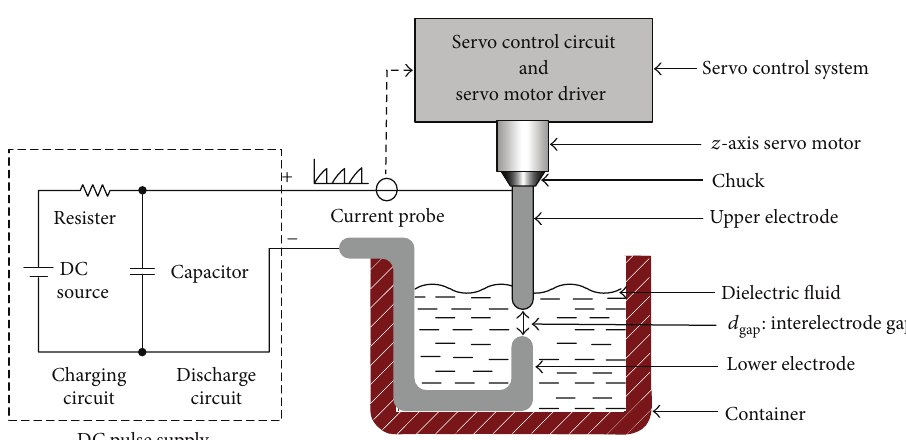
Figure 2: Architecture of preparing nanometal colloid by